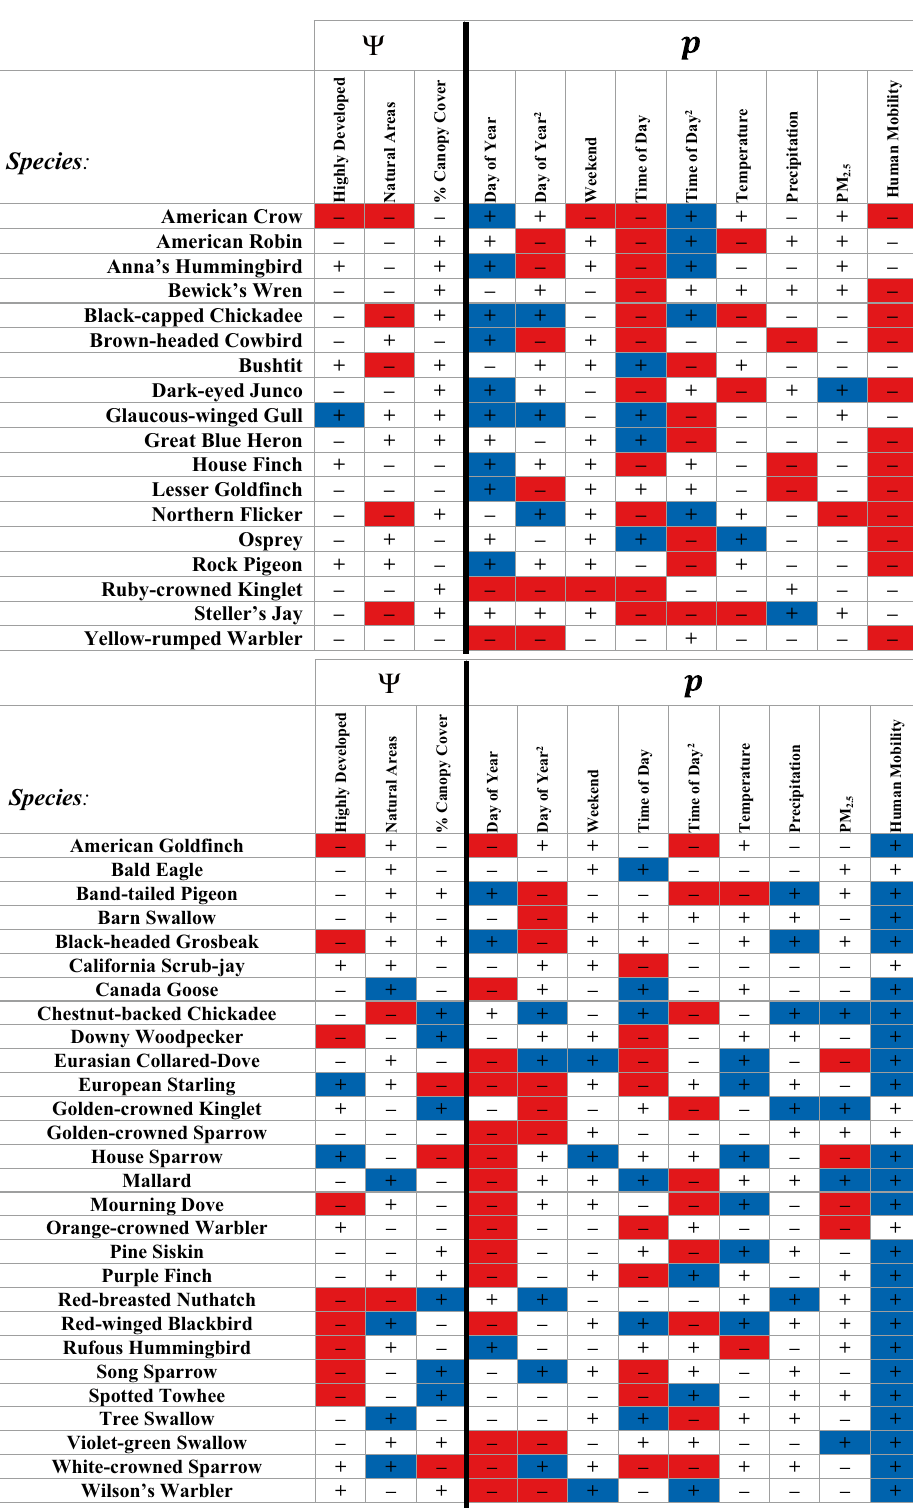
Figure 3. Results of single-season occupancy models by species. The top panel includes results for species that were less likely to be detected at higher levels of human mobility, and the bottom panel includes results for species that were more likely to be detected at higher levels of human mobility. The first three covariates were included as predictors of occupancy, with highly developed and natural areas shown relative to the less developed category (not shown). The next nine covariates (including day of year, day of year 2 , weekend, time of day, time of day 2 , temperature, precipitation, PM 2.5 , and human mobility) were included as predictors of detection. Blue boxes indicate statistically significant, positive effects (p < 0.05), and red boxes indicate statistically significant, negative effects. White boxes indicate effects with coefficient estimates that were not statistically different from zero. Complete model results are provided in Appendix